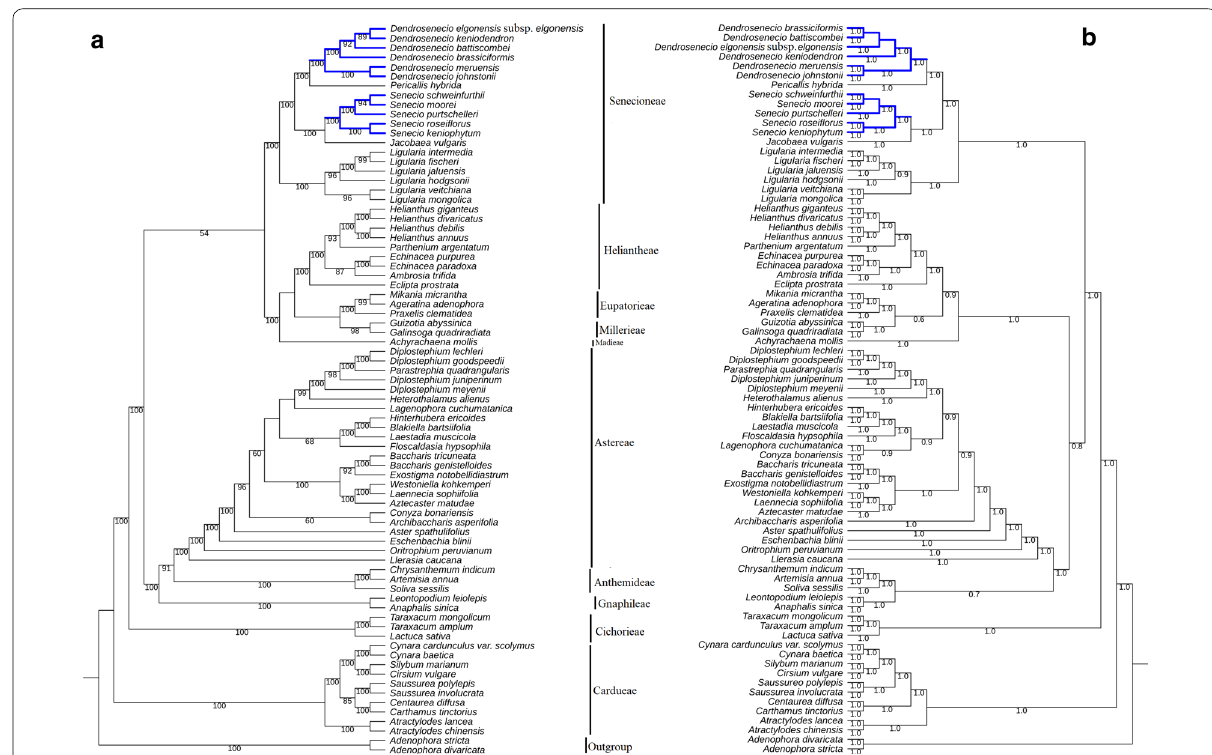
Fig. 7 Phylogenetic relationships of 75 species of Asteraceae inferred from an unpartitioned multi-gene dataset using a Maximum Likelihood (ML) and b Bayesian Inference